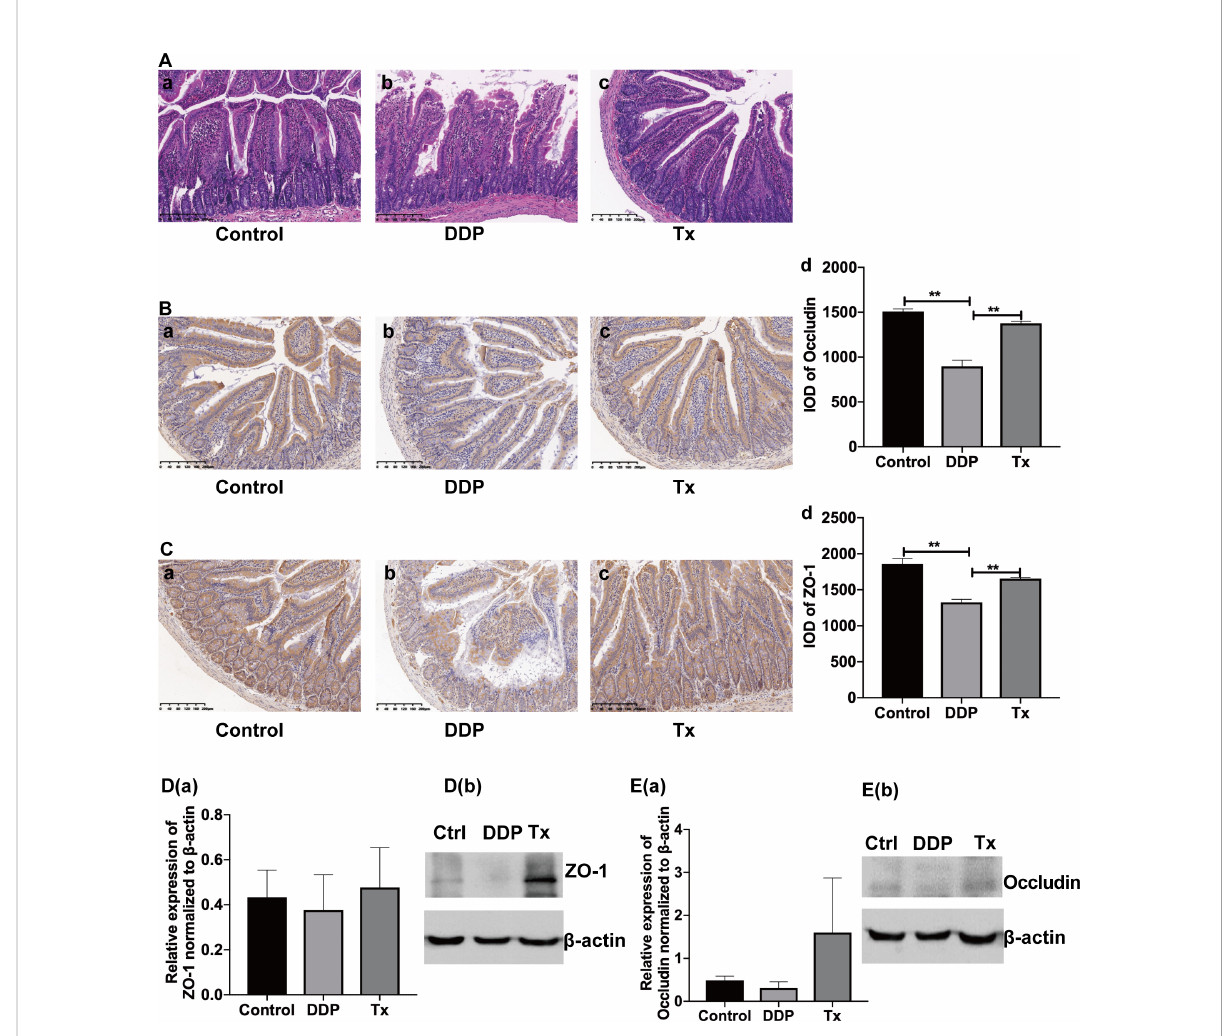
FIGURE 4 Protective Effect of LJAW on the Intestinal Mucosal Barrier in Cisplatin-induced Pica in Rats. (A) HE staining of representative intestine tissue sections obtained from rats treated with (A) vehicle control, (B) cisplatin or (C) cisplatin and LJAW. (B) Immunohistochemistry staining of occludin in jejunum tissue (A – C) . The expression of occludin in jejunum tissue was quanti fi ed by integrated optical density (IOD) (D) (n = 3, data are presented as mean ± sem, normality was tested by Shapiro-Wilk normality test, p values were determined by using one-way ANOVA, **, p < 0.01). (C) Immunohistochemistry staining of ZO-1 in jejunum tissue (A – C) . The expression of ZO-1 in jejunum tissue quanti fi ed by integrated optical density (IOD) (D) (n=3, data are presented as mean ± sem, normality was tested by Shapiro-Wilk normality test, p values were determined by using one-way ANOVA, **, p < 0.01). (D) Protein expression of ZO-1 in jejunum tissue. D(a) western blots showing total levels of ZO-1 in Control-, DDP-, and LJAW-treated rats jejunum, D(b) Bar graphs showing mean ZO-1 levels determined by densitometey(n=3, data are presented as mean ± sem, normality was tested by Shapiro-Wilk normality test, p values were determined by using one-way ANOVA). (E) Protein expression of Occludin in jejunum tissue. E(a) western blots showing total levels of Occludin in Control-, DDP-, and LJAW-treated rats jejunum, E(b) Bar graphs showing mean Occludin levels determined by densitometry (n=3, data are presented as mean ± sem, normality was tested by Shapiro-Wilk normality test, p values were determined by using one-way